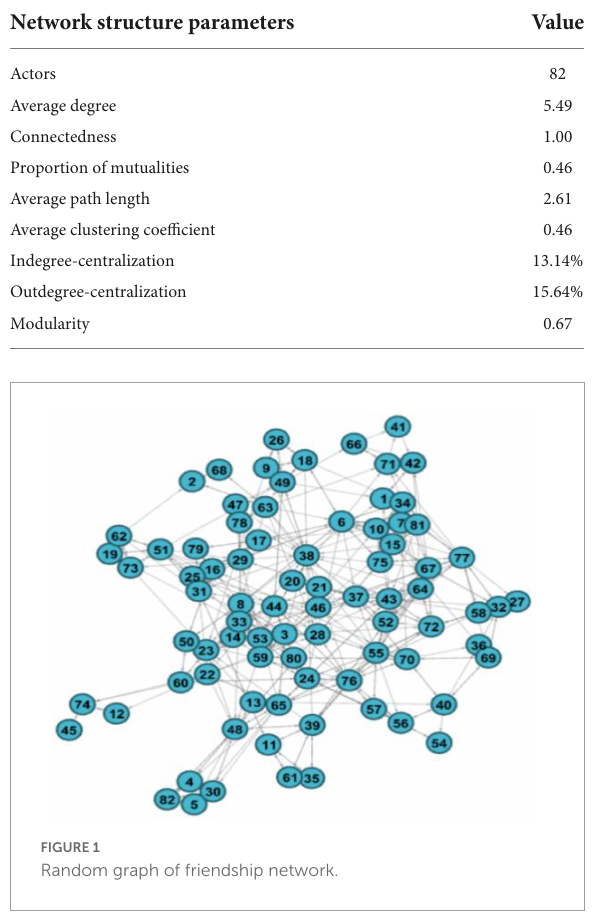
TABLE 1 Basic structural parameters of friendship network.